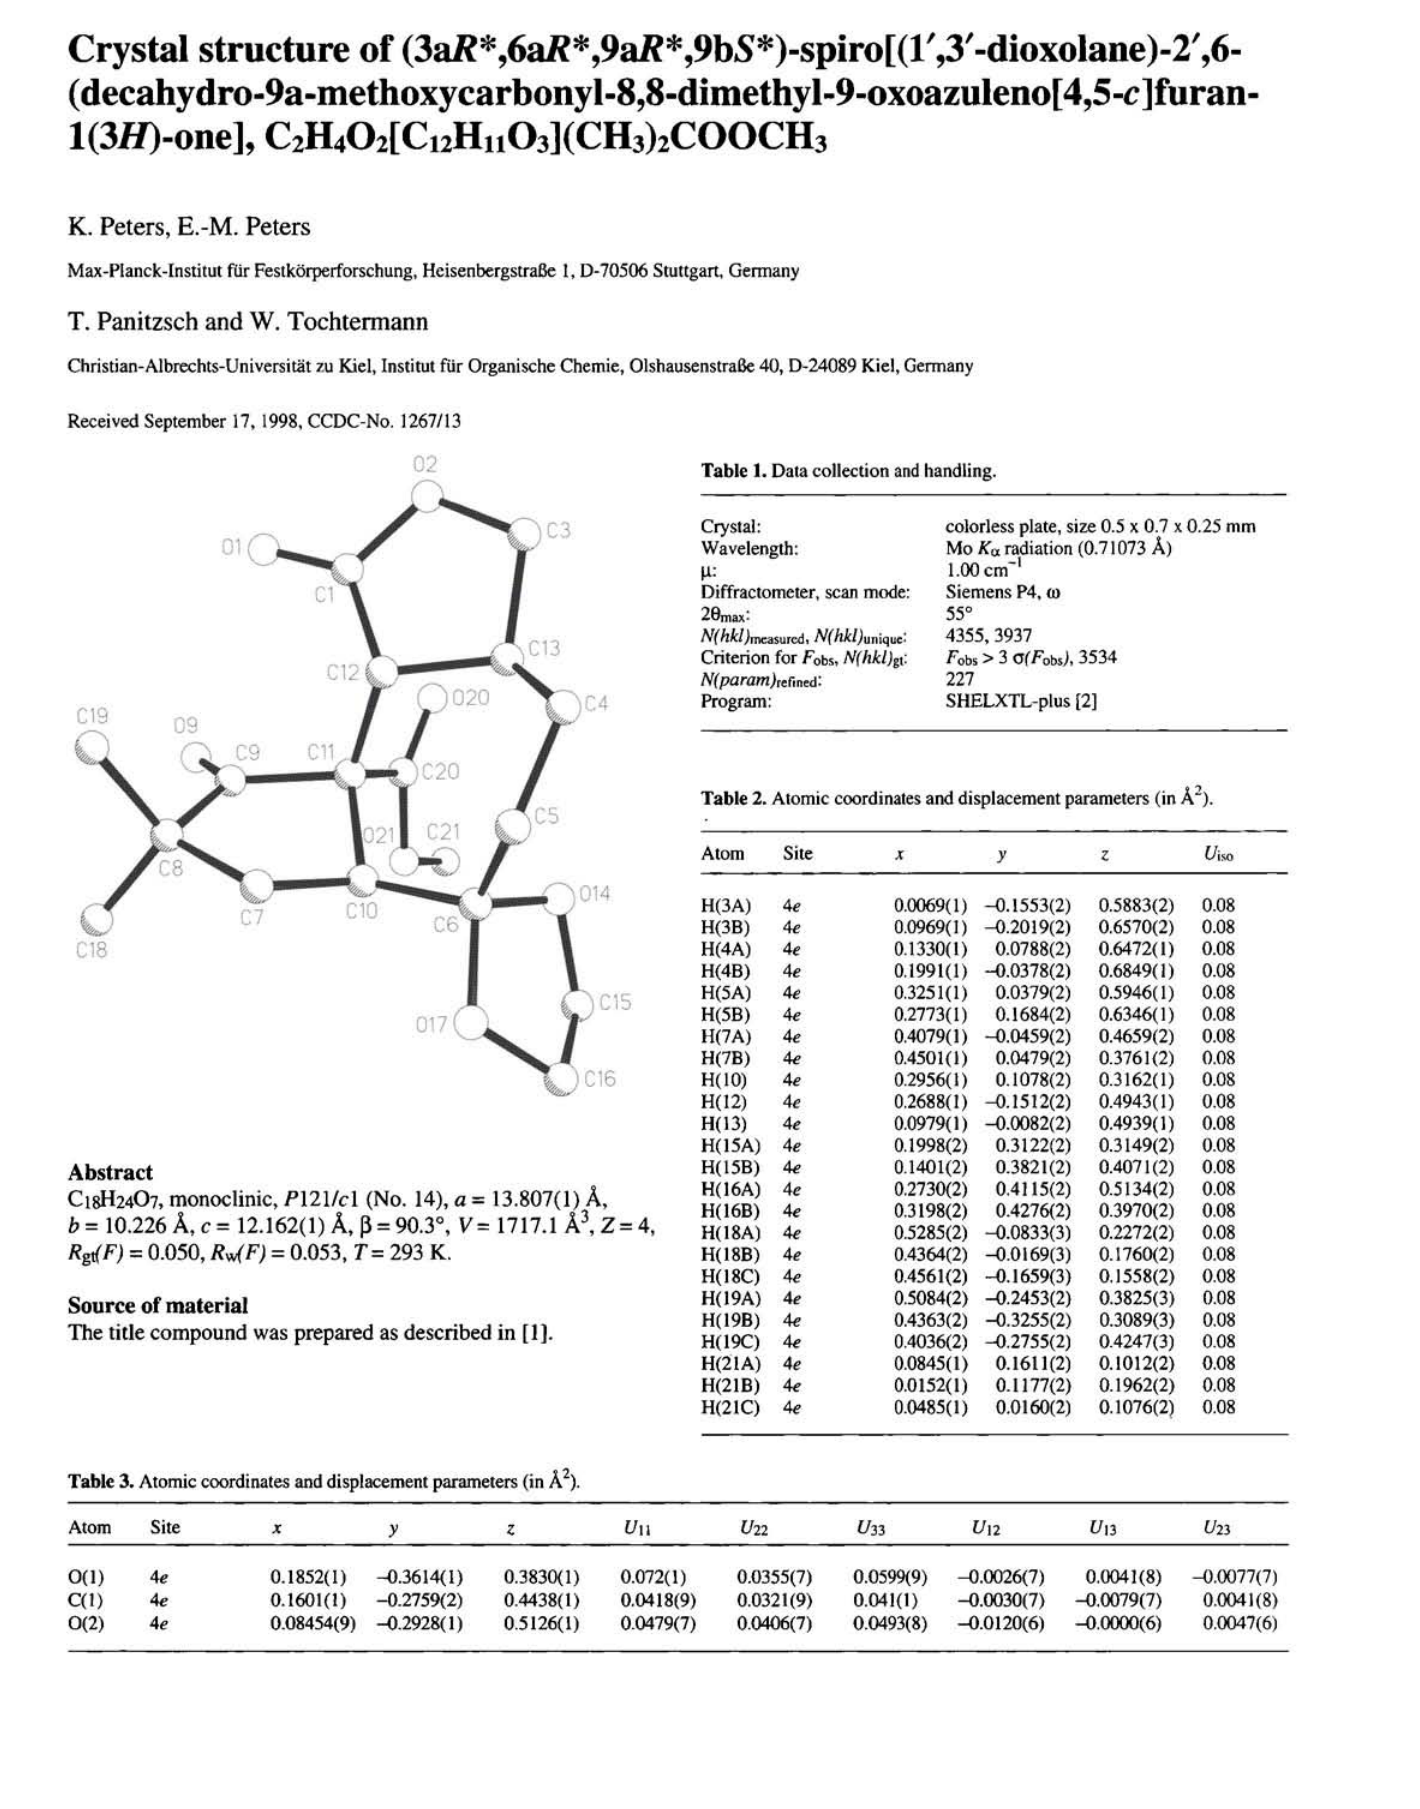
Table 3. Atomic coordinates and displacement parameters (in Â 2